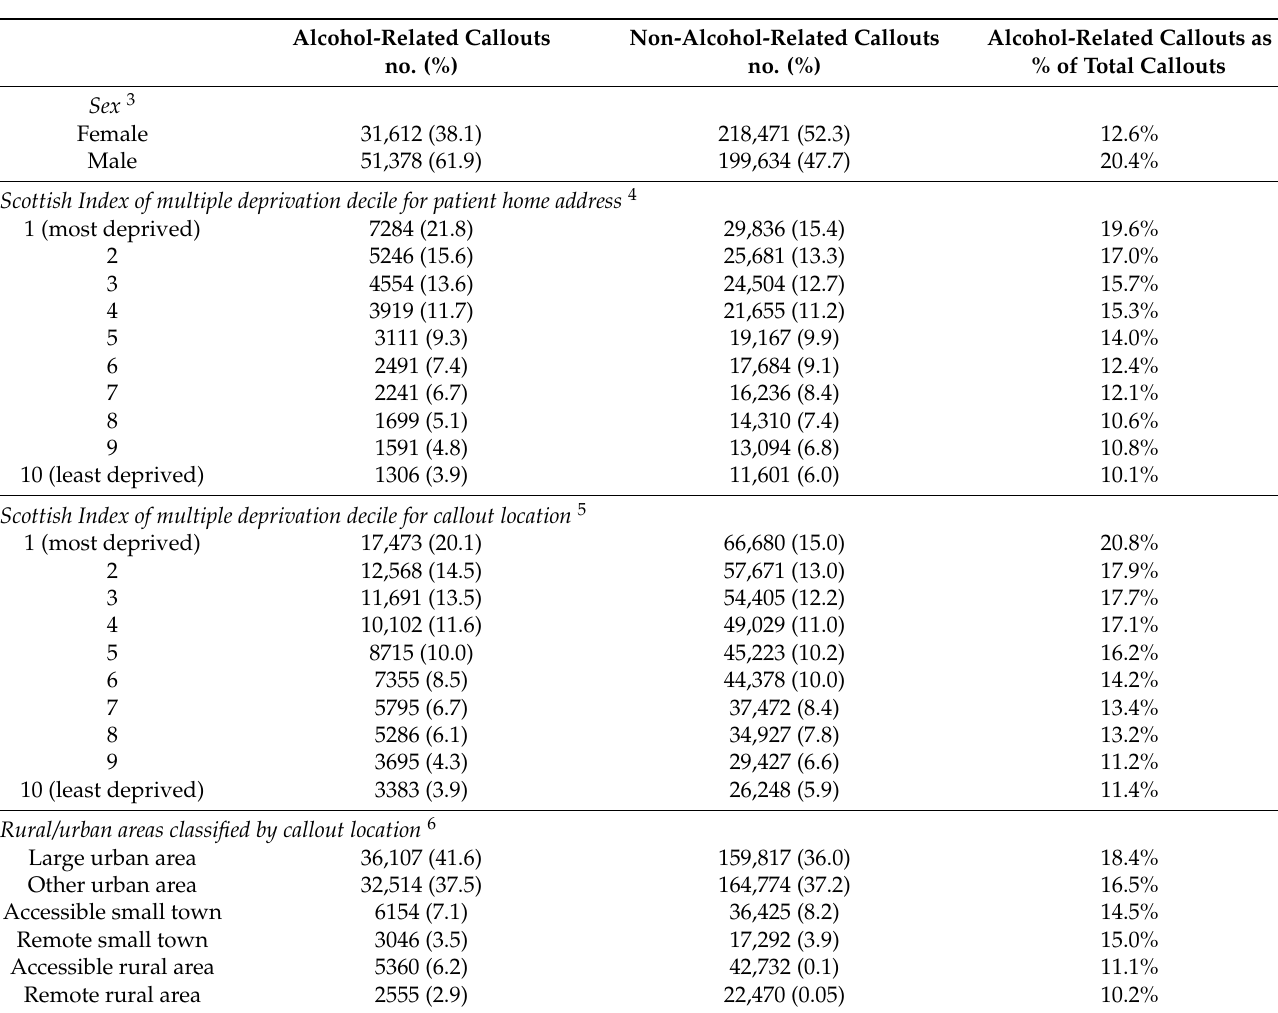
Figure 3. Distribution of alcohol-related callouts (panel A ) and non – alcohol – related callouts (panel B ) during hour of the day by age group.